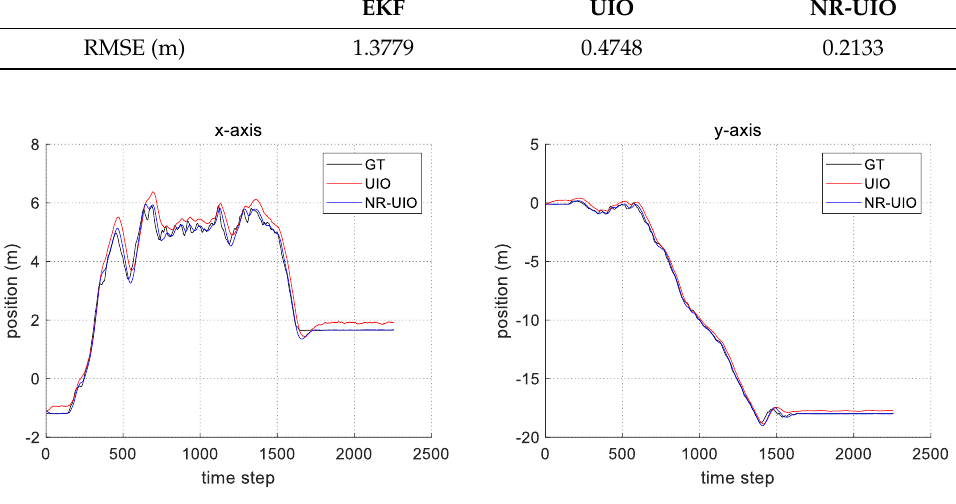
Figure 7. The comparison of the estimated position in x- and y-axes with